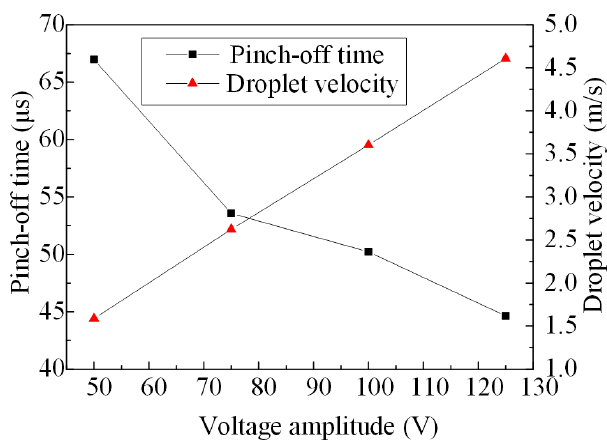
Figure 6. The pinch-off time and droplet velocity varies with different amplitudes of pulse voltages.